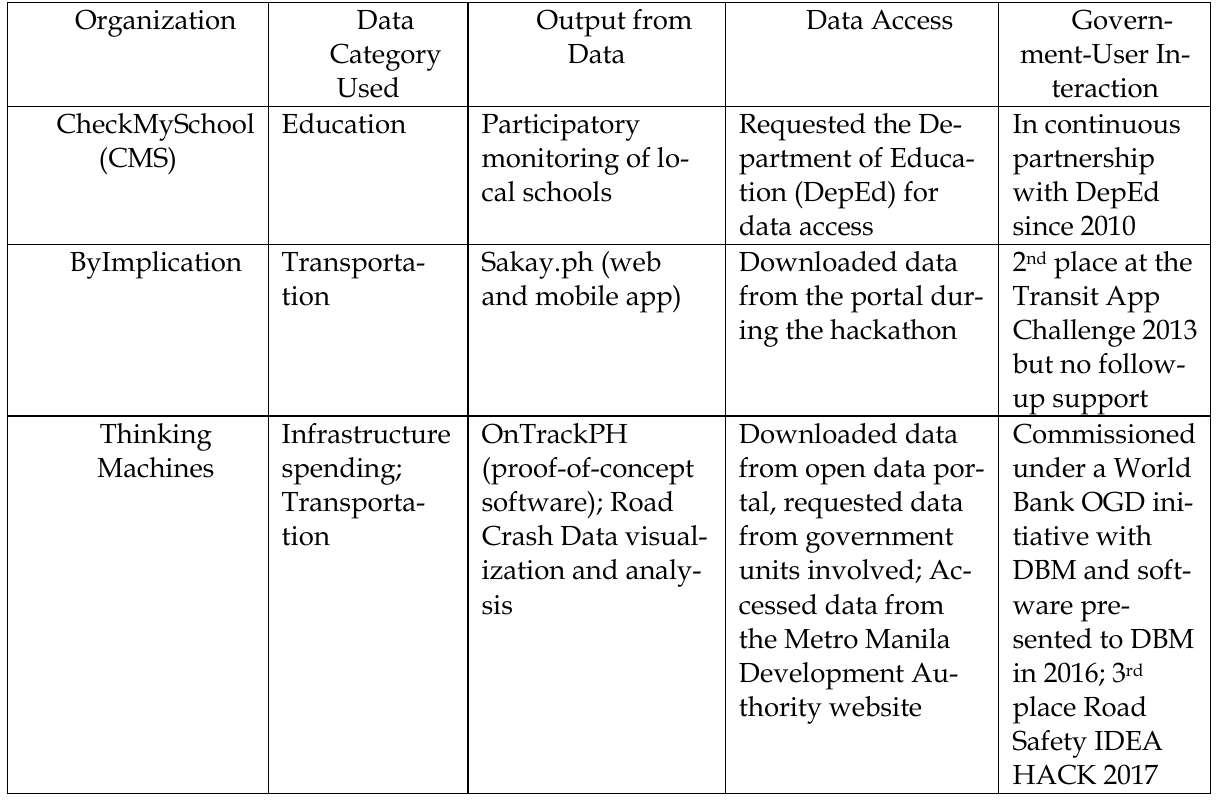
Table 5: Open Government Data Use of Organizations in the